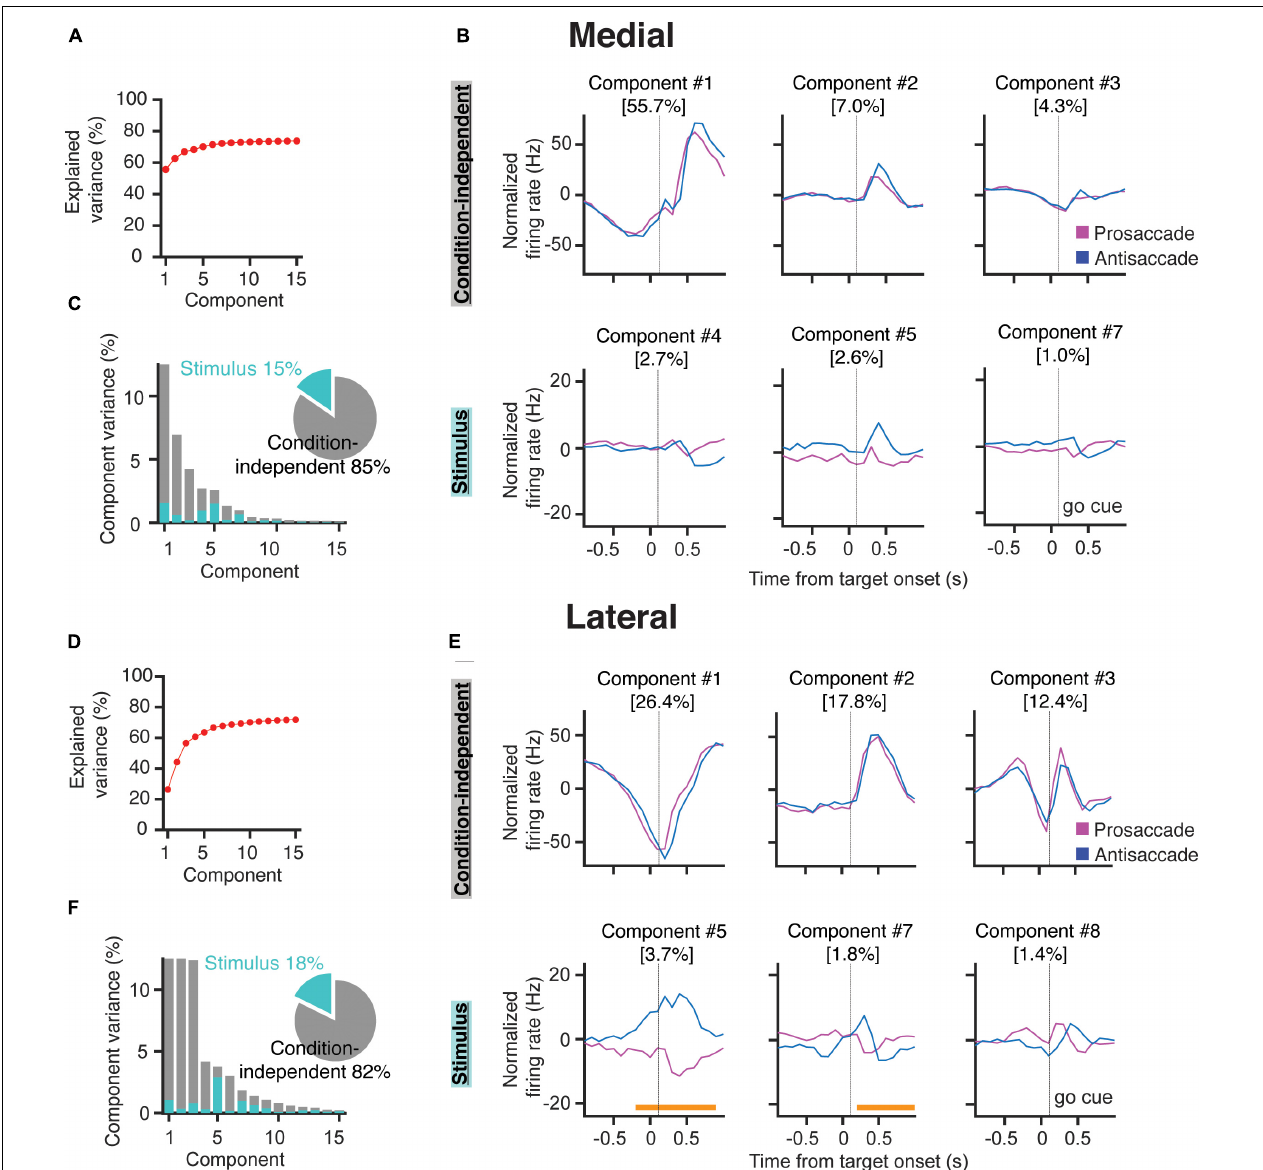
FIGURE 4 | Demixed PCA indicates that PCs in the lateral cerebellum encode stimulus identity. (A) Cumulative fraction of variance explained by dPCA in the medial cerebellum. The dotted line indicates an estimate of the fraction of variance in the data explained by the dPCA. (B) Projections of the PSTH’s of all the medial cerebellar PCs onto the most prominent decoding axes; top, first three condition-independent components; bottom, first three stimulus-related (pro/anti) components. Percentages denote the variance captured by each component. Time from instruction offset. (C) Variance of the individual dPCAs for the medial cerebellum. Each bar shows the proportion of the total variance. Gray bars depict condition-independent variance and cyan bars indicate stimulus-related (pro/anti) variance. The pie chart shows the total signal variance for stimulus-related and condition-independent components. (D–F) Same as in (A–C) but for the lateral cerebellum, orange horizontal bars in (E) indicate the time during which the stimulus can be decoded from the population firing